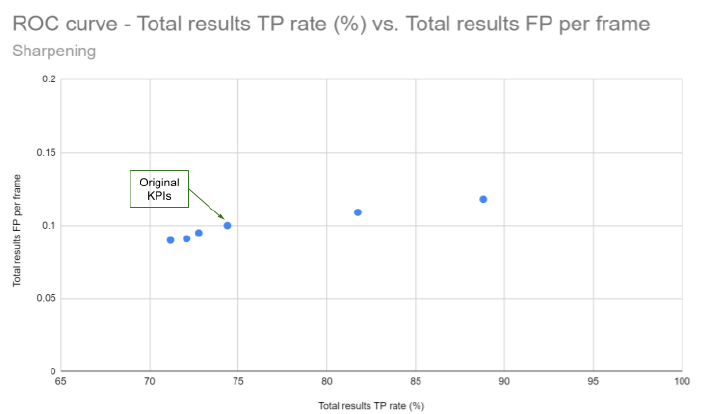
Figure 12. ROC curve showing TP rate vs. FP per frame for the 5 configurations tested and test on original images.